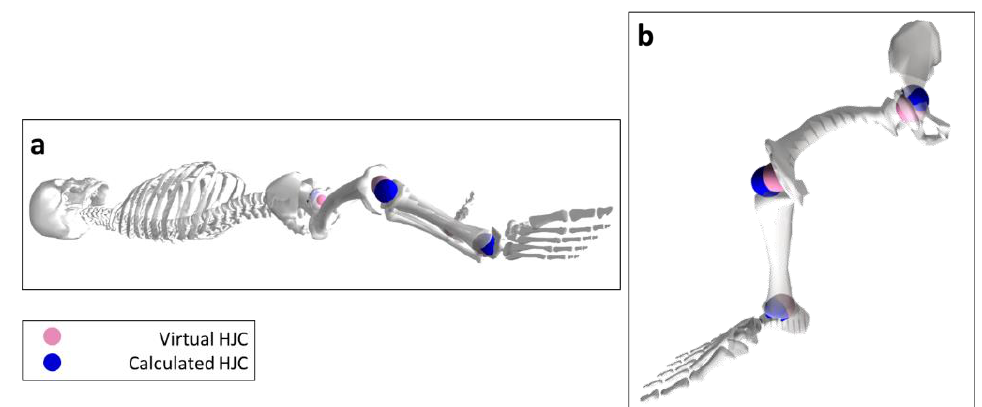
Figure 2. Subject-specific OpenSim model displaying the virtual joint center marker positions in pink and the calculated joint center marker positions in blue. ( a ) Right-side view of the musculoskeletal model in the supine position and ( b ) isolated right lower extremity. Head and torso bodies are not to scale.